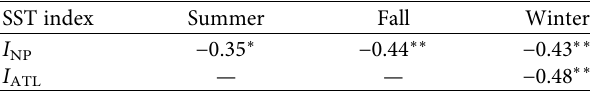
Table 1: The lead-lag and contemporaneous correlation coeffi- cients between I NP and I ATL of key areas in each season and the regional average frequency of the winter SSECEs in North